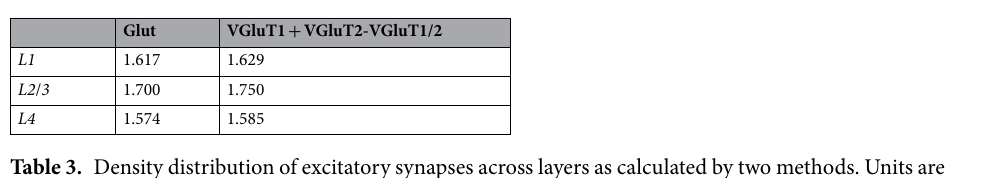
vesicular glutamate transporters (VGluTs) at the presynaptic site, with the majority of excitatory synapses con- taining VGluT1, and a smaller population, mostly concentrated in layer 4, VGluT2. In addition, some synapses express both VGluT1 and VGluT2 64 . Thus, the density of glutamatergic synapses should be approximately equal to the densities of VGluT1 and VGluT2 synapses minus VGluT1/VGluT2 synapses to prevent double counting of the same synapse. This was indeed the case, as seen in Table 3.